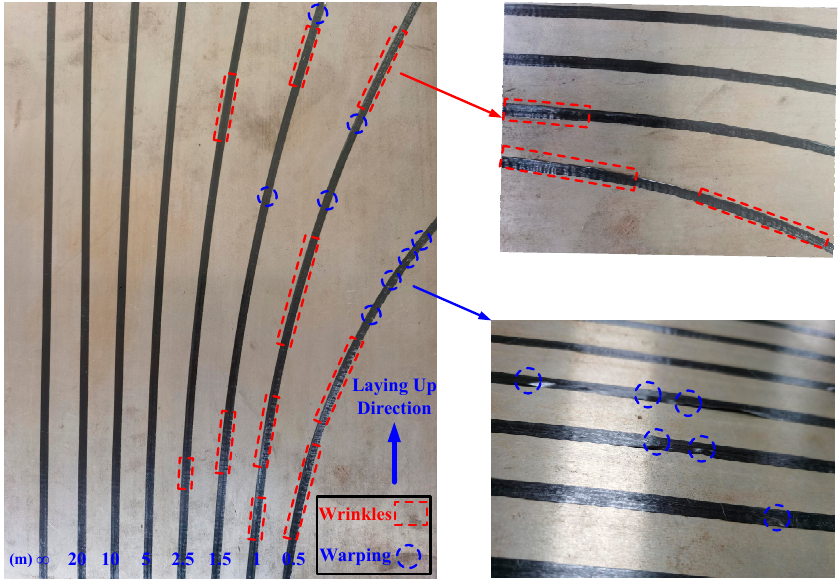
Figure 14. Results of experiment with different steering radii and close-up view of the defects.